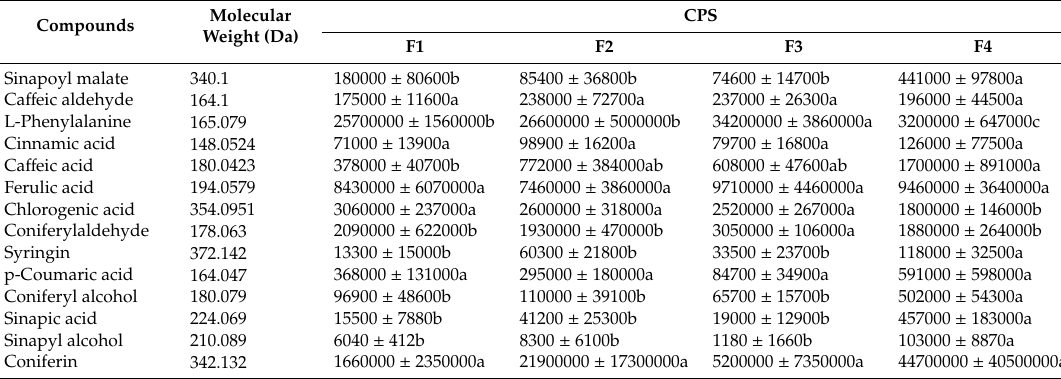
Table 1. Content and type of metabolites in phenolic acid biosynthesis pathway.